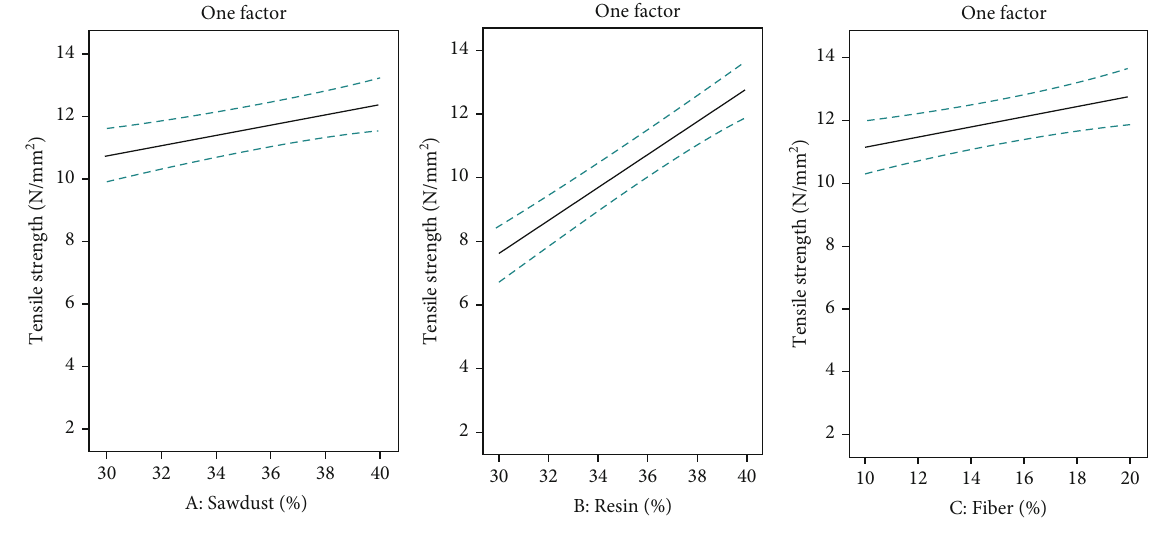
Figure 1: The e ff ect of factors on tensile strength.